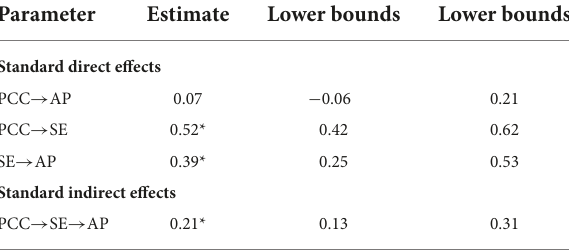
TABLE 3 Direct and indirect effects